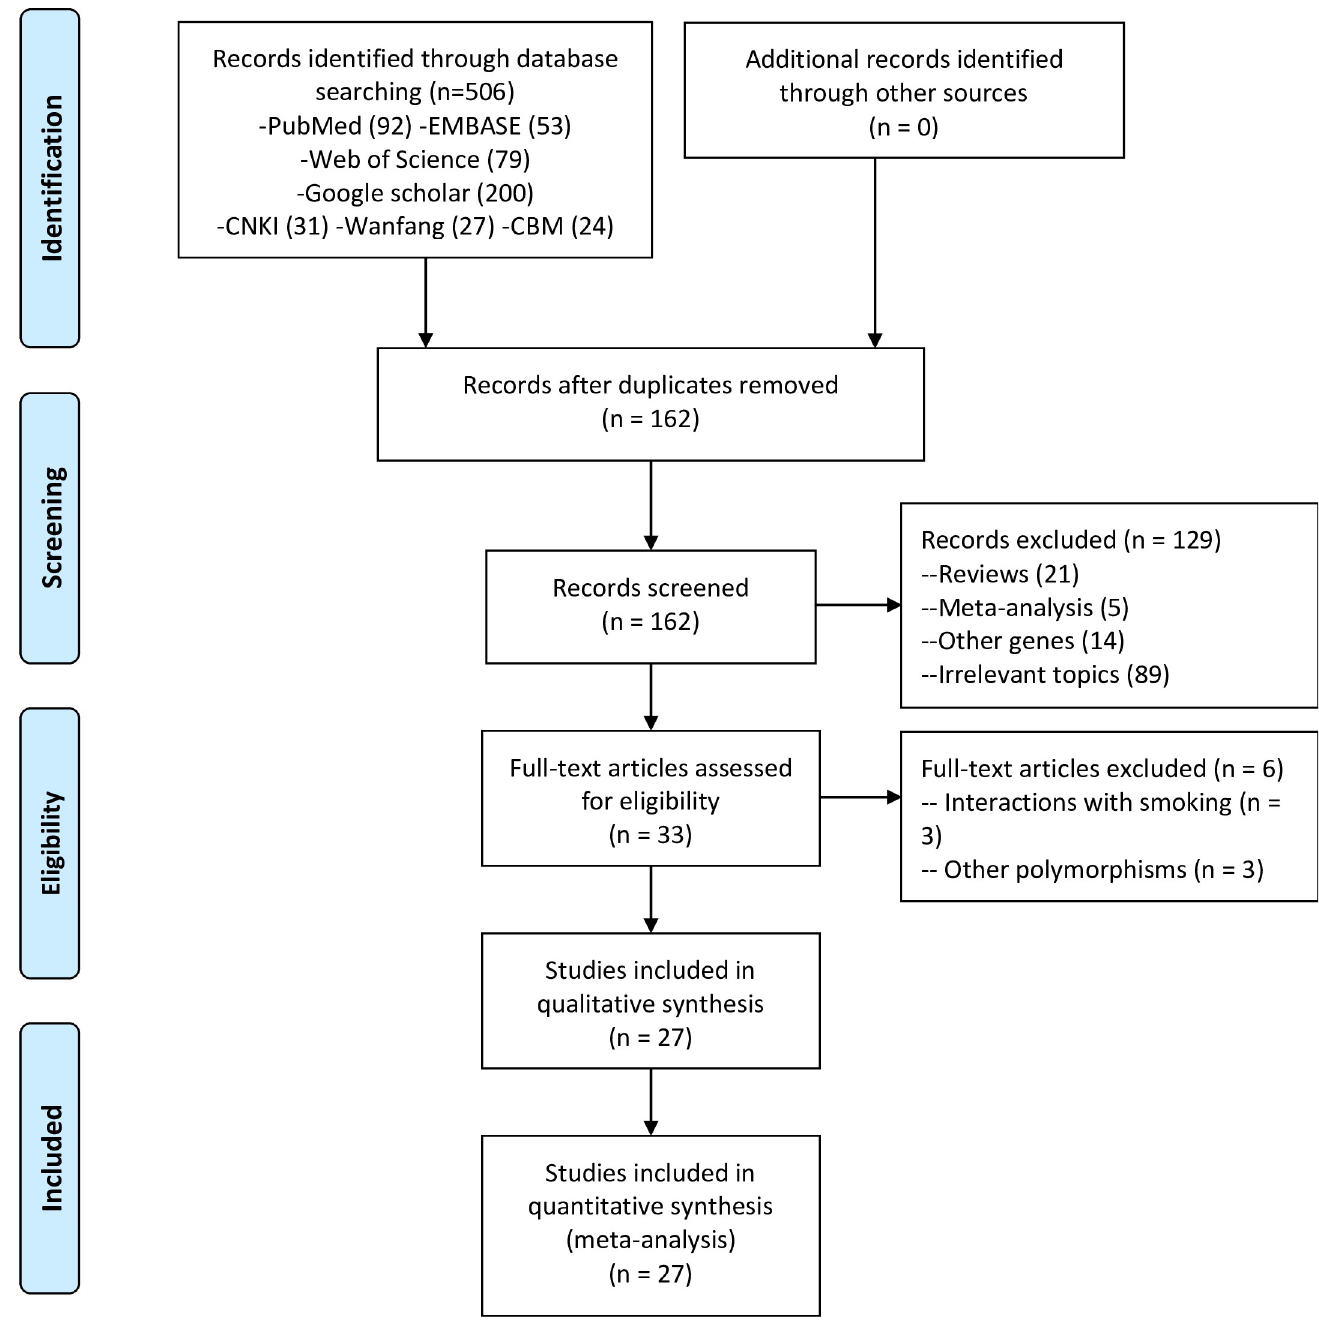
Fig 1. Flowchart of literature search. TT vs CC+CT: OR = 1.65, 95%CI 1.03–2.65, p = 0.036; TT vs CC: OR = 1.92, 95%CI 1.18– 3.10, p = 0.008; Fig 2). Carriers of TT or CT genotypes had higher risk of peri-implant disease in Asian populations (OR = 1.96, 95%CI 1.26–3.05, p = 0.003) and were more vulnerable to IF/ IL (OR = 1.73, 95%CI 1.03–2.89, p = 0.037) compared with carriers of CC genotype.